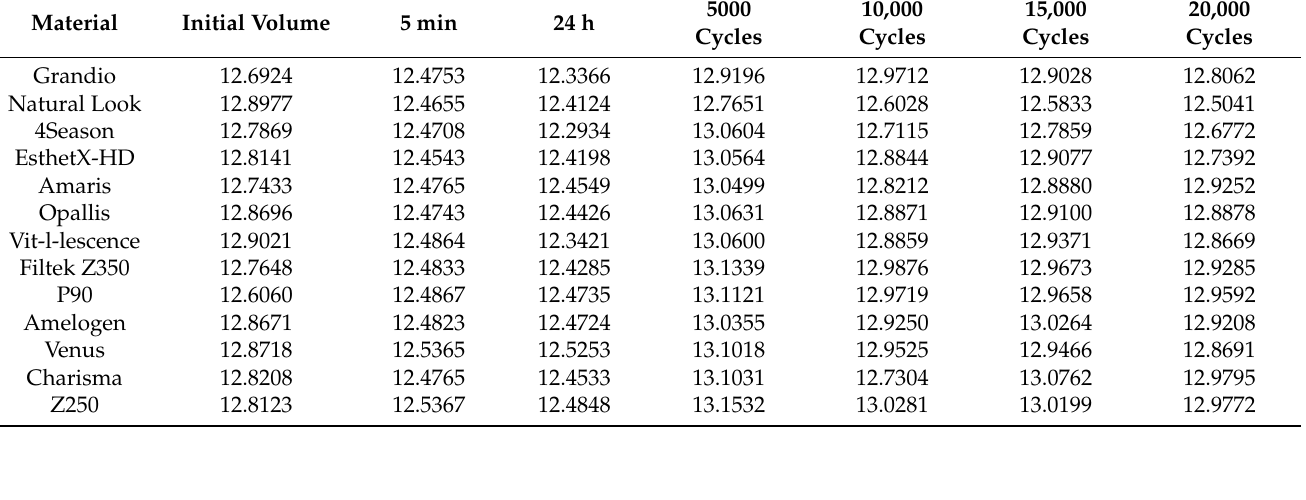
Table 4. Means of composites hygroscopic expansion at different aging cycles.